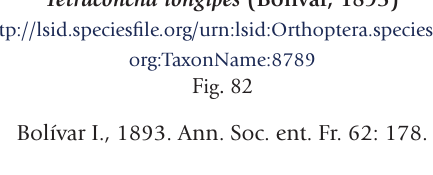
Color. —Head, antennae, pronotum and abdomen brown, face with a yellow spot, cerci yellow, tegmina with a black spot at their base, brown with yellow veinlets, bright yellow in the stridulatory area. Femora yellow-brown or green-brown (Figs 73, 96). Description. —Males. Head and antennae: Fastigium of vertex tu- berculated, narrow, separated from fastigium of frons, little sul- cate. Eyes rounded, well projecting. Antennae longer than body, exceeding hind femora, first segment well developed, compara- tively to the other species of the genus. Legs: Fore coxae armed with a small spine. Fore tibiae furrowed dorsally, distinctly wid- ening above tympanum, conchate on both sides. Fore femora armed on inner ventral side with 6–7 spines, fore tibiae with 6–7 spines + 1 spur on inner ventral side and 6 small spines on outer ventral side, 5 spines + 1 spur on outer dorsal side, mid femora armed with 6–7 spines on outer ventral margin, mid tibiae with 15–17 spines on outer and inner ventral sides + 1 spur on each side, and 3 spines + 1 spur on inner dorsal side, hind femora armed with 1–2 small spines on outer and inner ventral sides, hind tibiae with many spines on ventral and dorsal sides + 3 spurs on each side. Thorax: Pronotum narrowing anteriorly, flat above, anterior margin straight, posterior margin rounded, hu- meral sinus well developed, lobes of pronotum rounded. Teg- mina narrow with rounded apices. Cubital area of the left tegmen narrow (Table 1). Wings longer than tegmina. Stridulatory area of left and right tegmina shown in Fig. 28; stridulatory file strong- ly curved and interrupted in the mid section by a bulge,